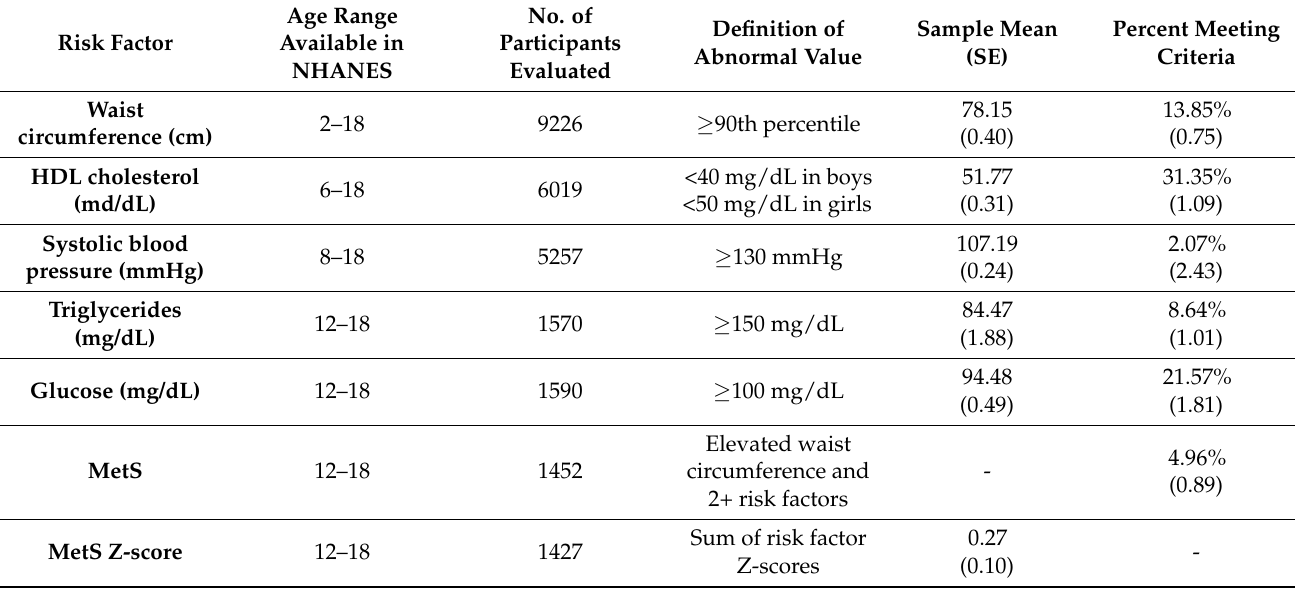
Table 1. Definitions of Abnormal Values for Risk-Factor